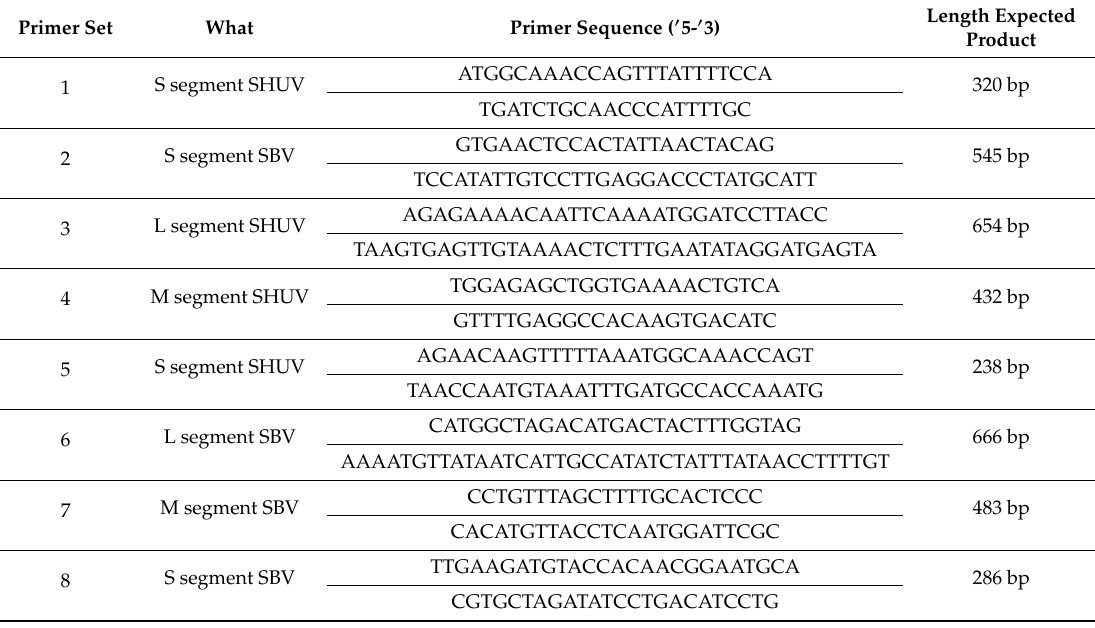
Table 1. Primers used in conventional